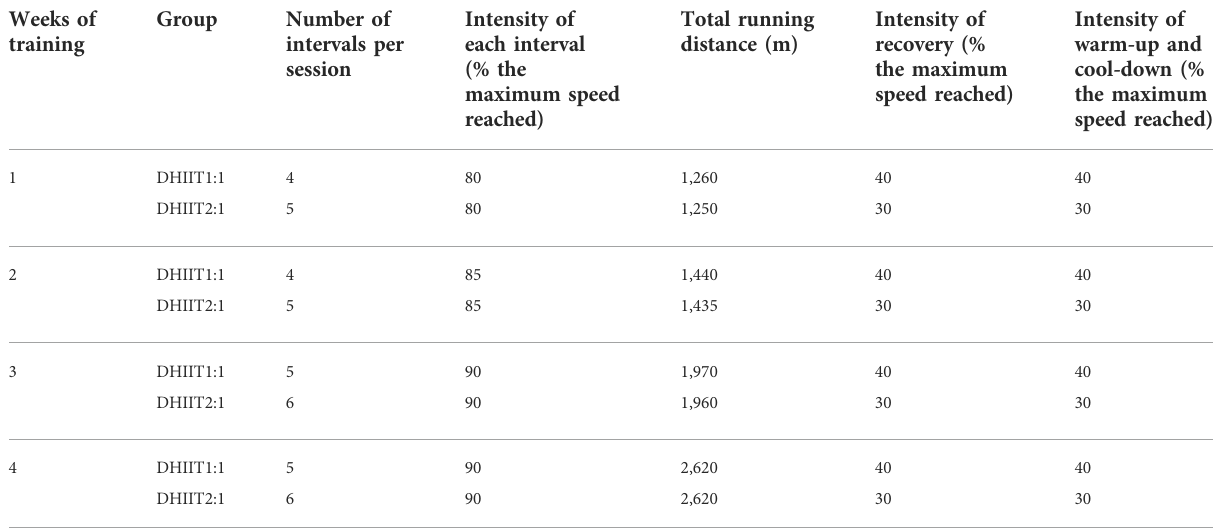
TABLE 1 The high intensity interval training protocols for both training groups.